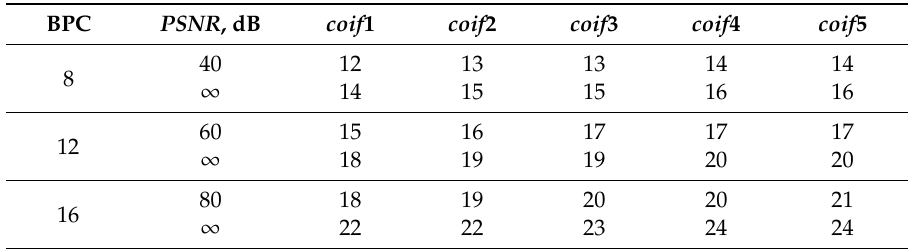
Table 12. Minimum values of r , at which the result of 3D medical images DWT with coiflets reaches high and maximum